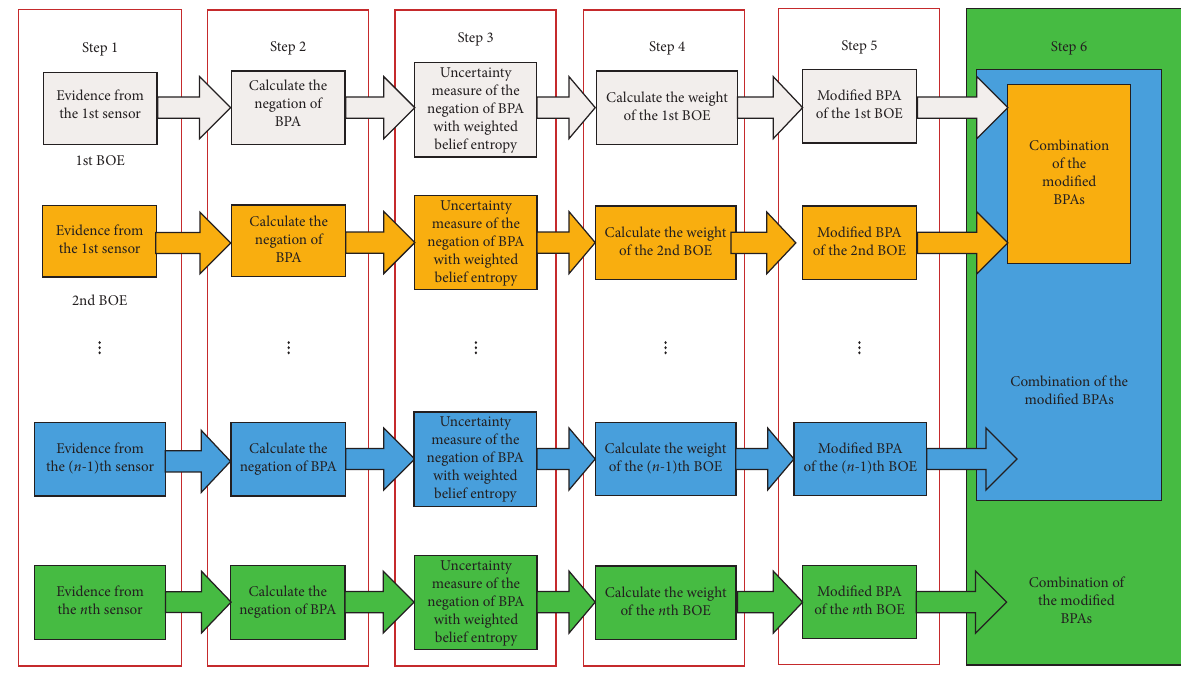
Figure 1: Flow chart of data fusion based on the weighted belief entropy and the negation of BPA. Table 1: BPAs of artificial data.